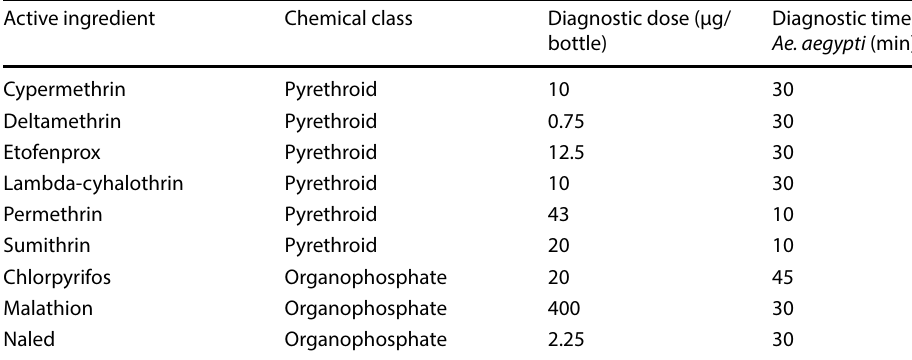
Active ingredient Chemical